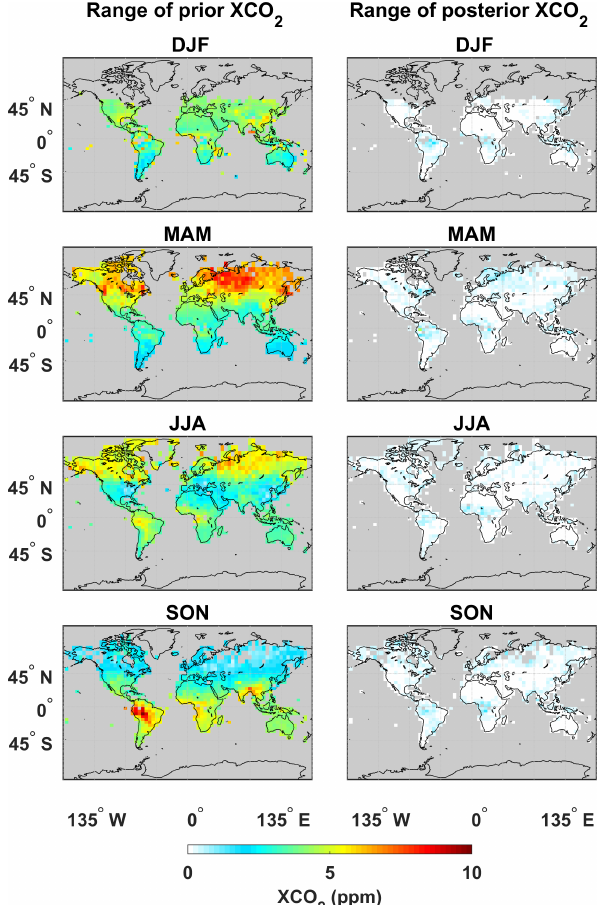
Figure 4. Total number of OCO-2 LN and LG XCO 2 observations (left column) and the corresponding seasonally averaged multi- model (NASA-CASA, CASA-GFED, SiB-4, and LPJ biosphere models) mean GEOS-Chem-simulated prior XCO 2 (right column) in 2015.